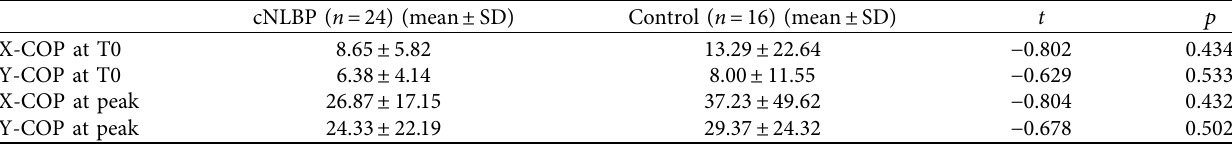
Table 3: The COP displacement between the cNLBP and control groups in the internal perturbation task.